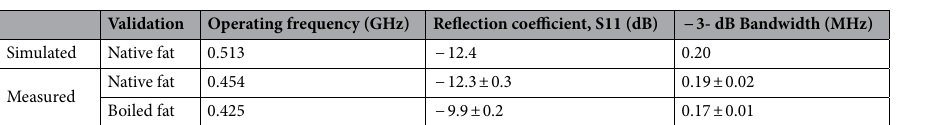
Table 4. Summary of the simulated and measured antenna